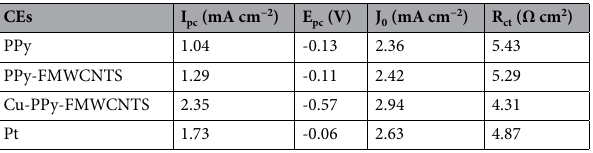
Table 2. Cyclic voltammetry and Tafel polymerization measurements of various counter electrodes.